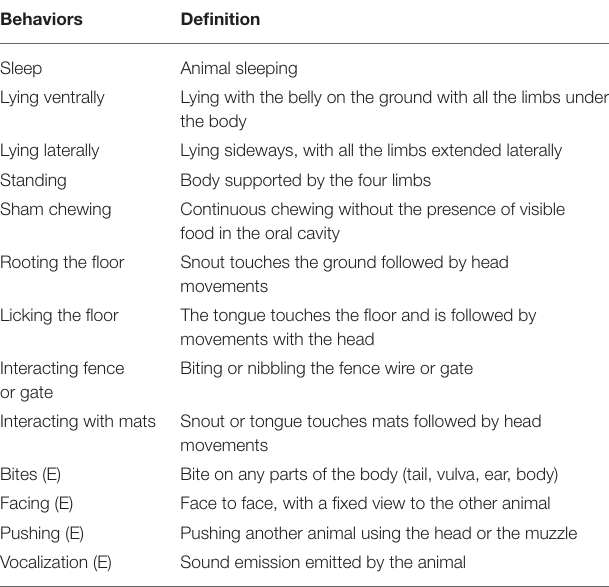
TABLE 1 | Definition of behaviors for behavioral observation of pregnant